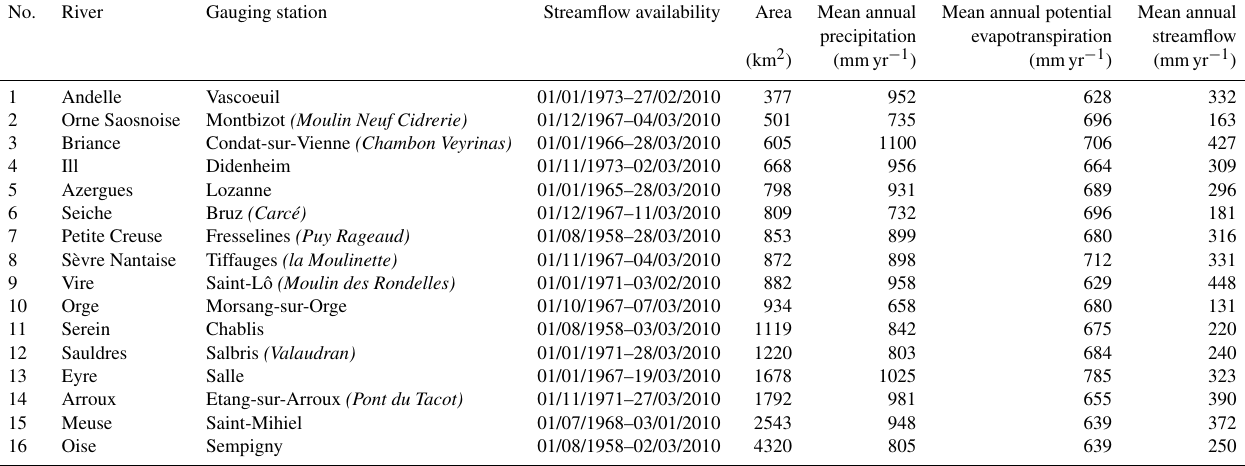
Table 1. River and gauging stations, periods with available streamflow observations and area and main hydroclimatic characteristics of the 16 catchments (ranked from the smallest to the largest). The mean annual streamflow is computed over the period of streamflow availability. The mean annual precipitation and evapotranspiration are computed over the 1958–2010 period.